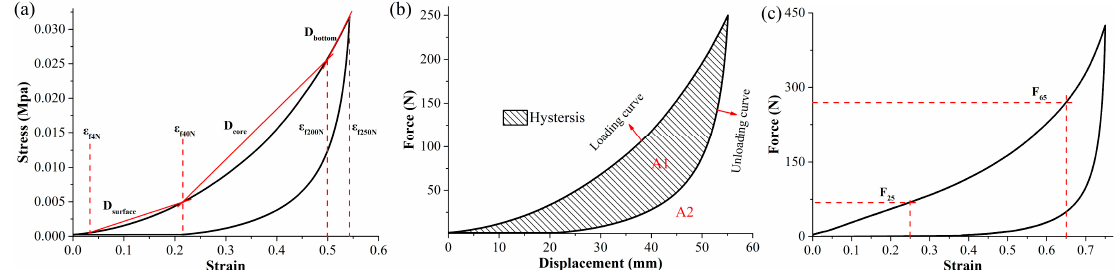
Figure 4. Illustration of calculating method of mechanical characteristics of mattress filled.